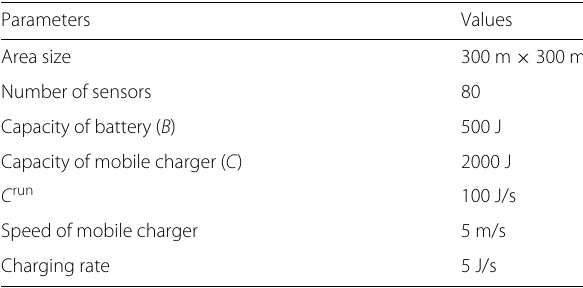
Fig. 11 Performance comparison in terms of network